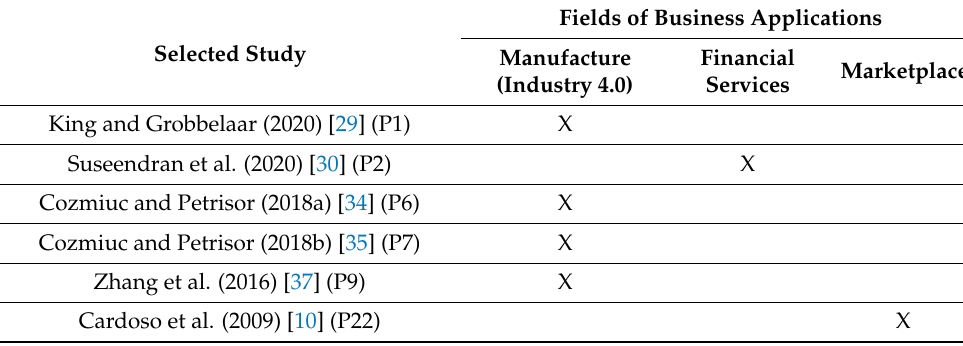
Table 4. Selected studies by field of application in business.